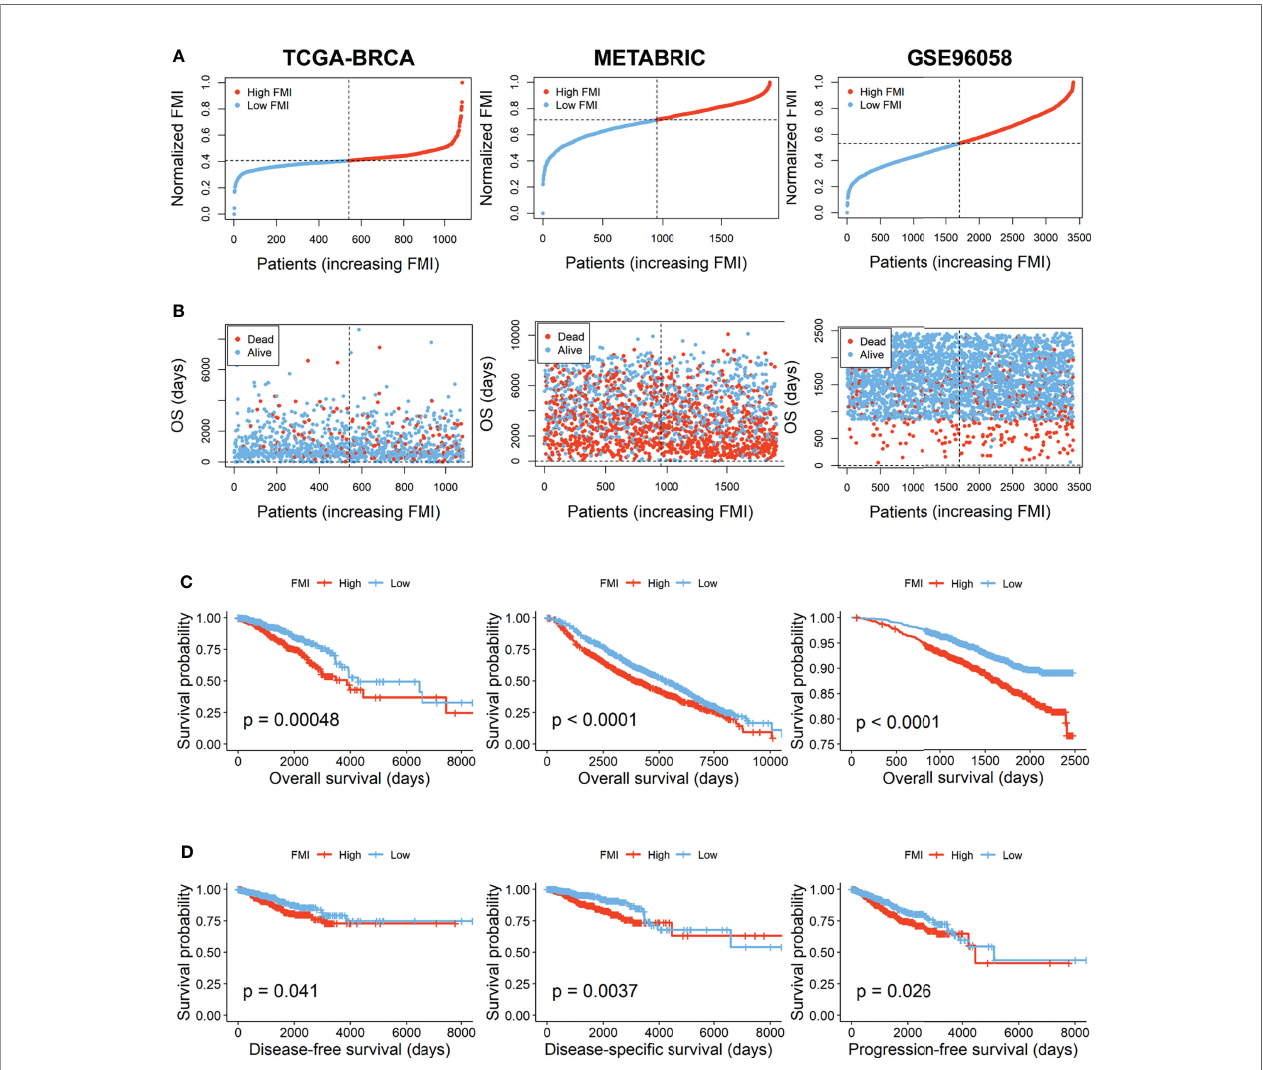
FIGURE 3 | Evaluation and validation of the utility of FMI in training set and validation sets. (A) Distribution of the patients ’ normalized FMI score. (B) Patients ’ overall survival time along with their FMI score. (C) K-M analyses of OS between high- and low-FMI groups. (D) K-M analyses of DFS, DSS, and PFS between high- and low-FMI groups in training set. FMI, fatty acid metabolism index; K-M, Kaplan – Meier; OS, overall survival; DFS, disease-free survival; DSS, disease-speci fi c survival; PFS, progression-free